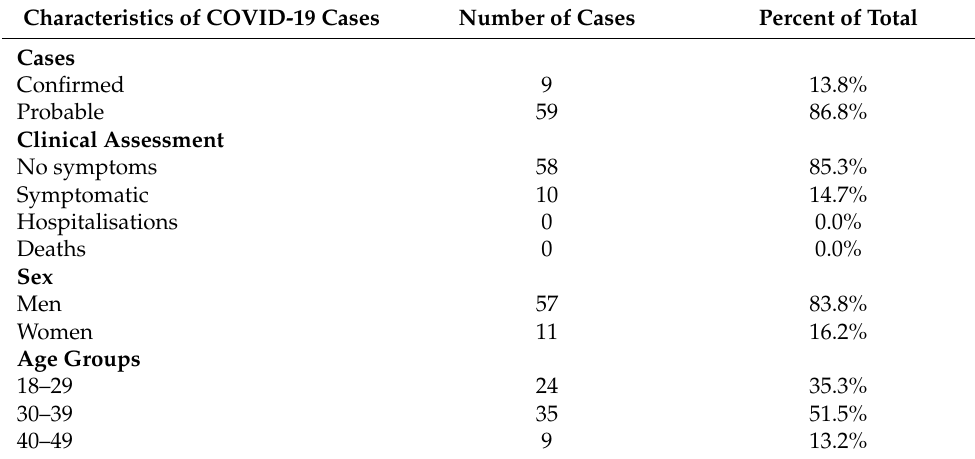
Table 1. Characteristics of COVID-19 cases in the outbreak ( n =